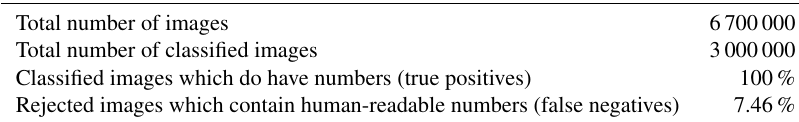
Table 3. True positives vs. false-negative error rates in detecting the clock display of all digitised images.